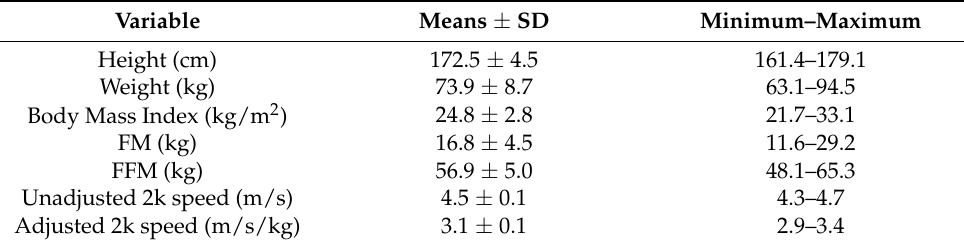
Table 1. Means ± SD of the studied